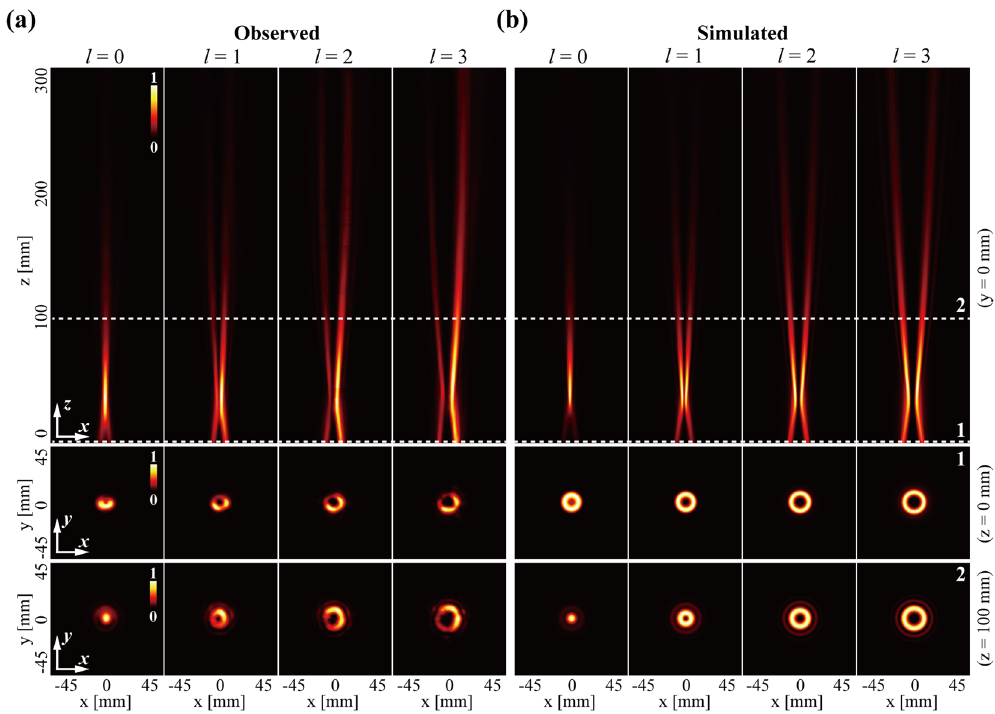
Figure 3. The propagation dynamics of the generated THz CAVBs with individual OAM states ranging from l = 0 to l = 3. The normalized intensity profiles of ( a ) the experimental results and ( b ) the simulated results for generating THz CAVBs. The first row: intensity profiles in the xz -plane ( y = 0 mm); the second row: intensity profiles in the xy -plane ( z = 0 mm); the third row: intensity profiles in the xy -plane ( y = 100